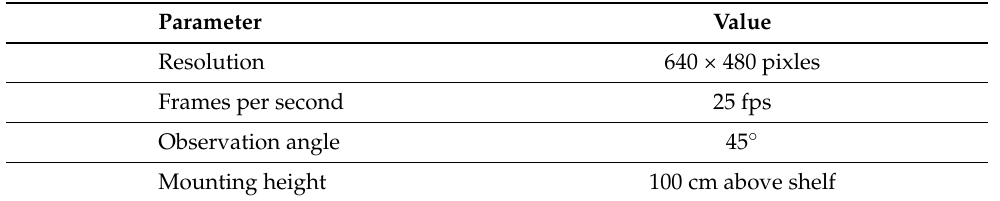
Table 3. The IR camera system specification.